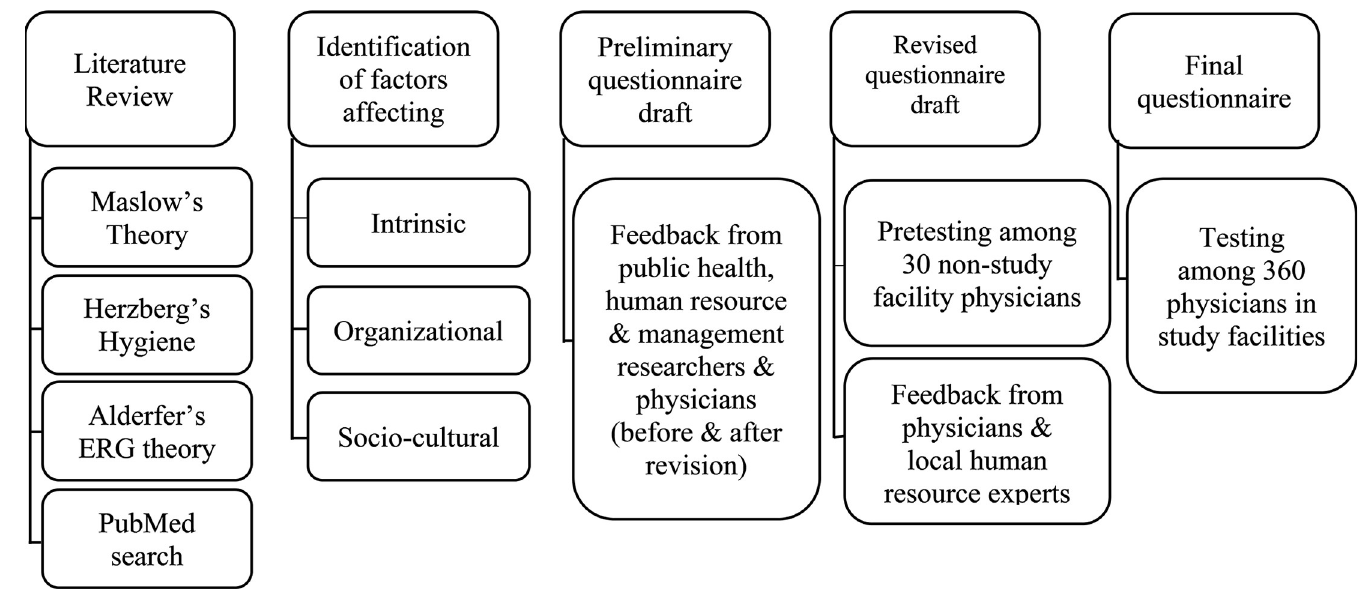
Fig 1. Summary of tool development and testing